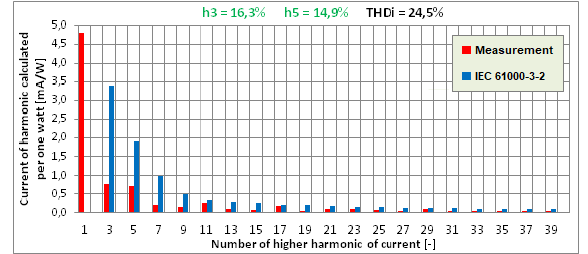
Fig. 2. Harmonic spectrum of current in 10 W LED lamp .